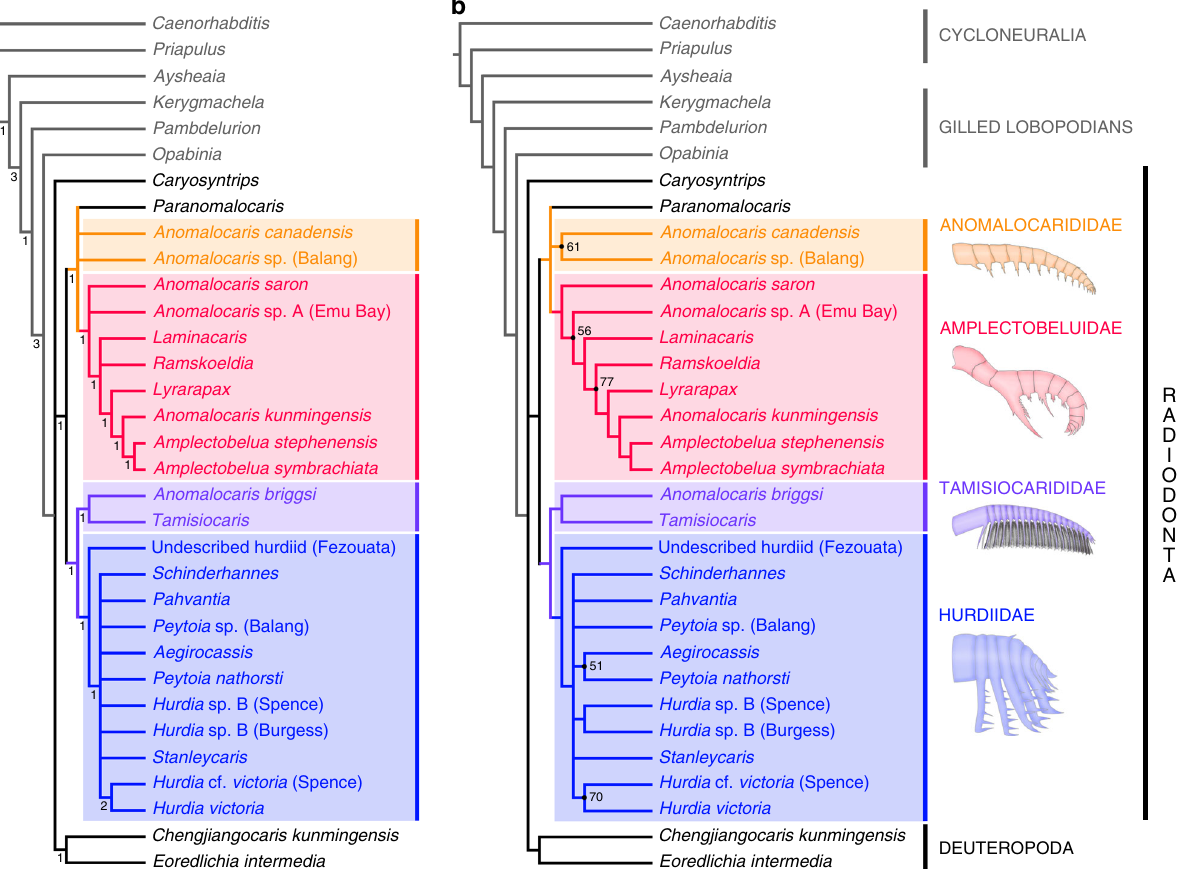
Fig. 2 Phylogenetic position of Pahvantia hastata . a Strict consensus of 144 most parsimonious trees (MPTs) at 104 steps under equal weighting (CI = 0.621, RI = 0.804), which shows that P. hastata belongs to the family Hurdiidae. Numbers at the nodes indicate Bremer support values. b The 50% majority-rule consensus of 144 MPTs at 104 steps under equal weighting (CI = 0.661; RI = 0.836). Numbers at the nodes indicate percentage of trees containing that node, and nodes without numbers were recovered in all trees. The same topology is recovered under implied weighting and different